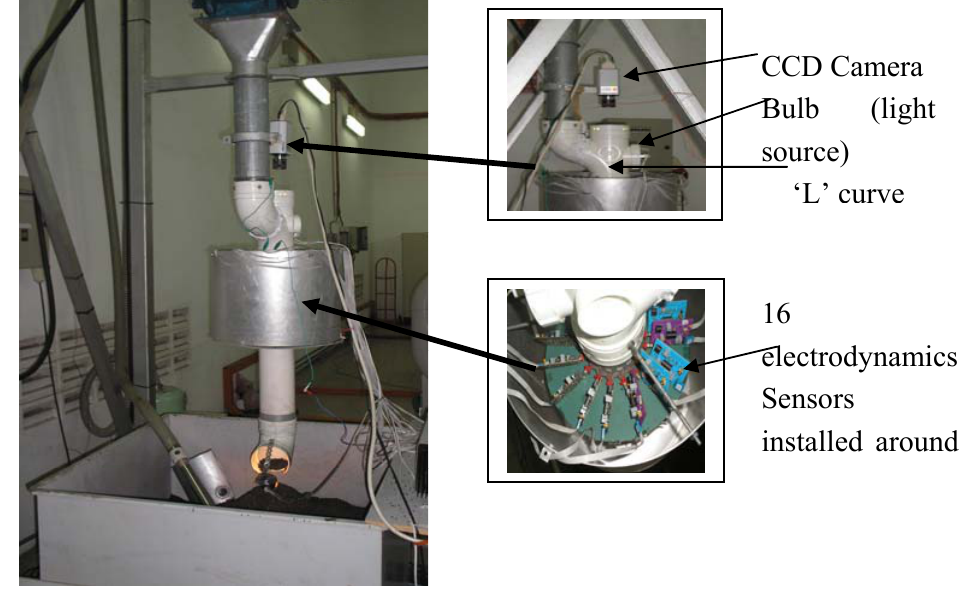
Figure 5. Experiment apparatus for data capturing